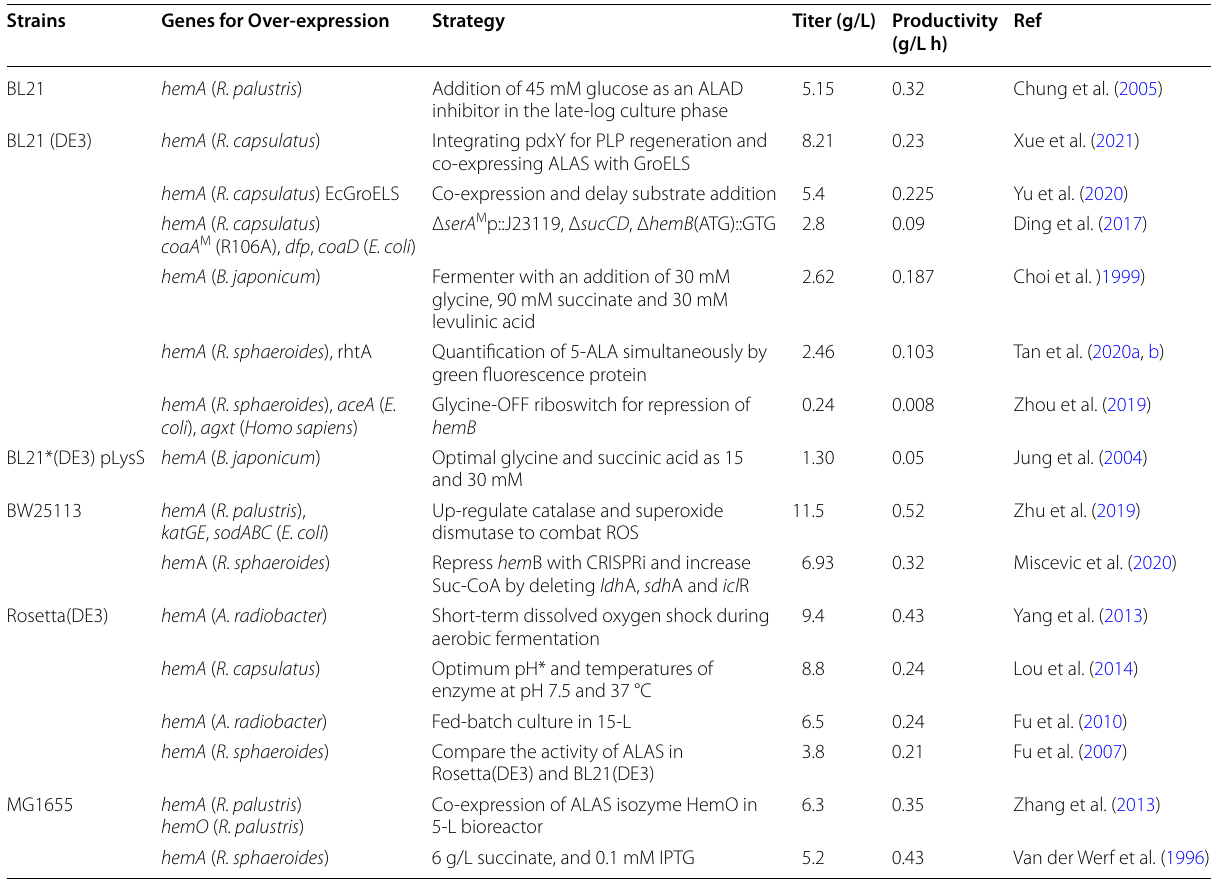
Table 2 Production of 5‑ALA via C4 pathway in Escherichia coli Strains Genes for Over‑expression